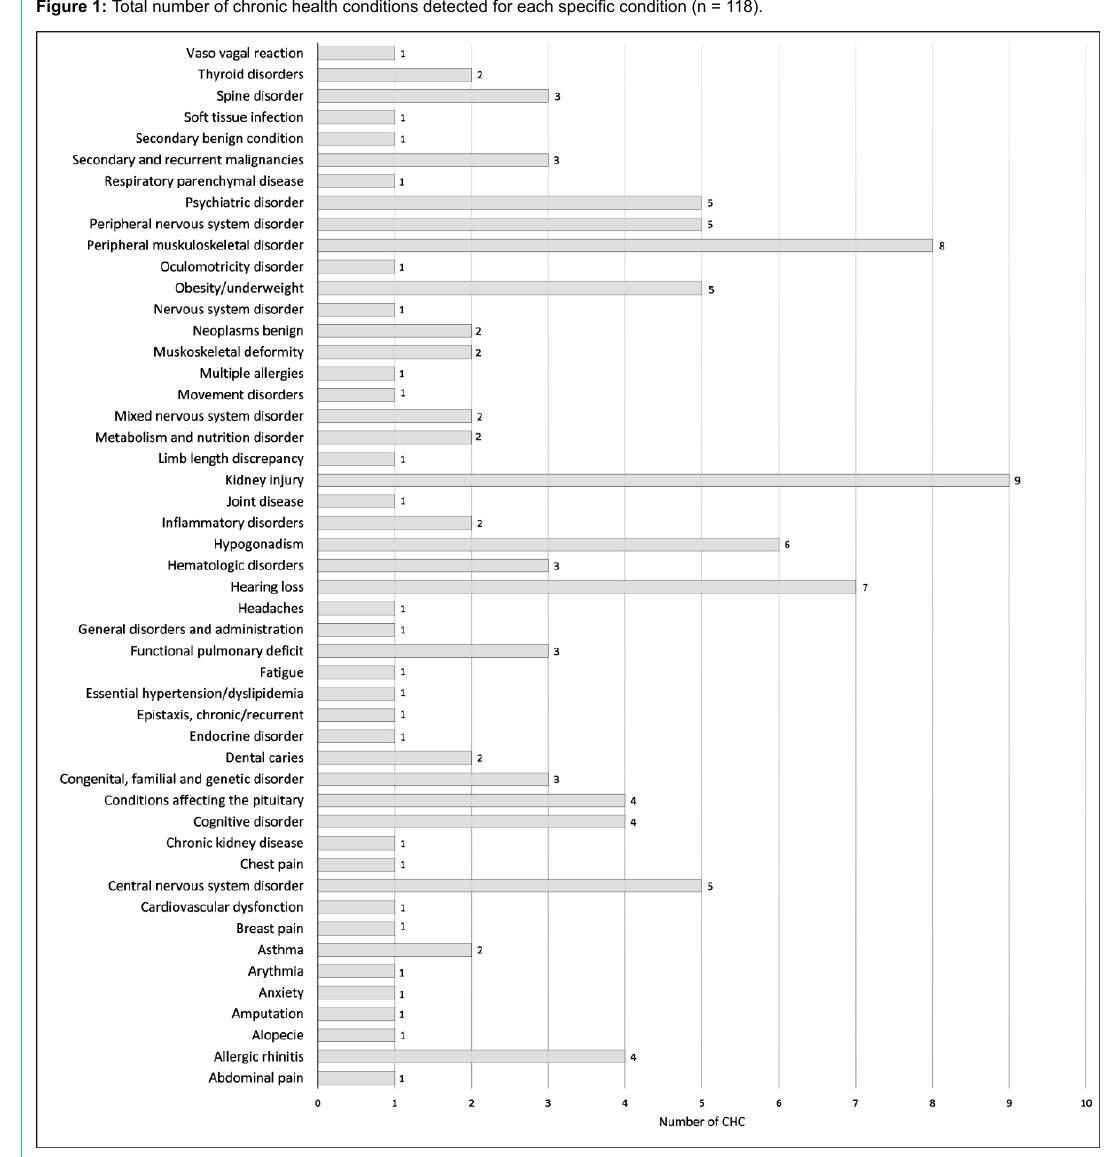
Figure 1: Total number of chronic health conditions detected for each specific condition (n =